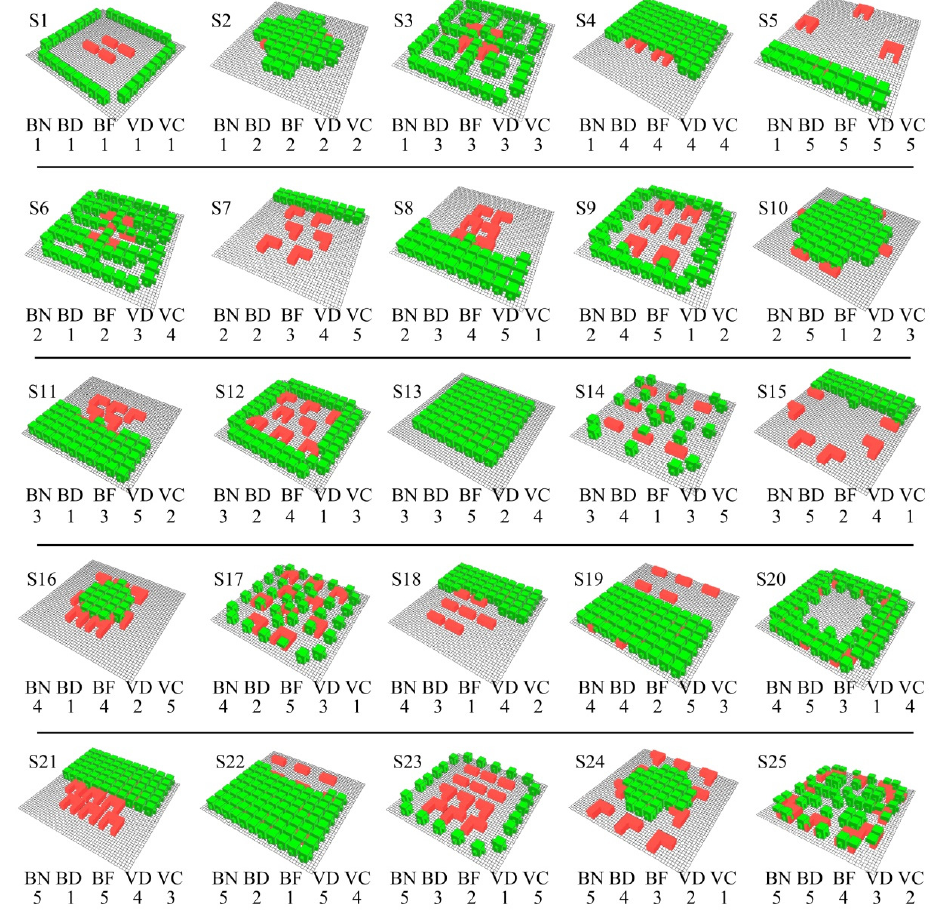
Figure 9. Schematic diagram of 25 experimental